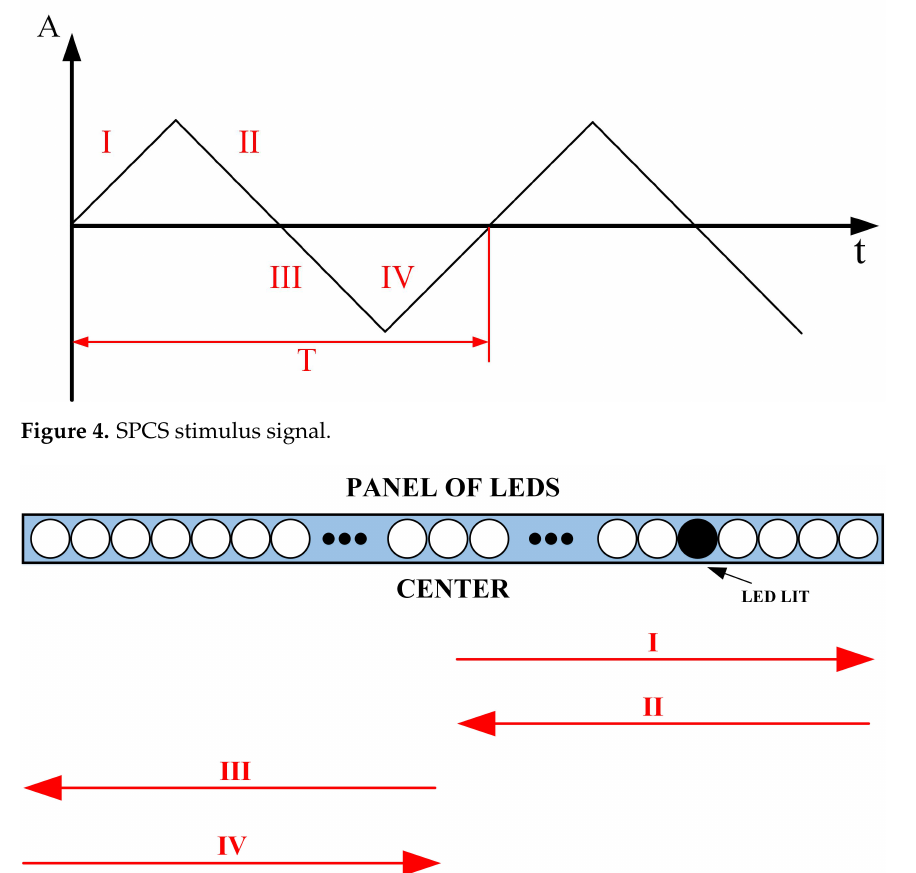
Figure 5. SPCS signal visualization pattern in the panel of LEDs for the triangular signal depicted in Figure